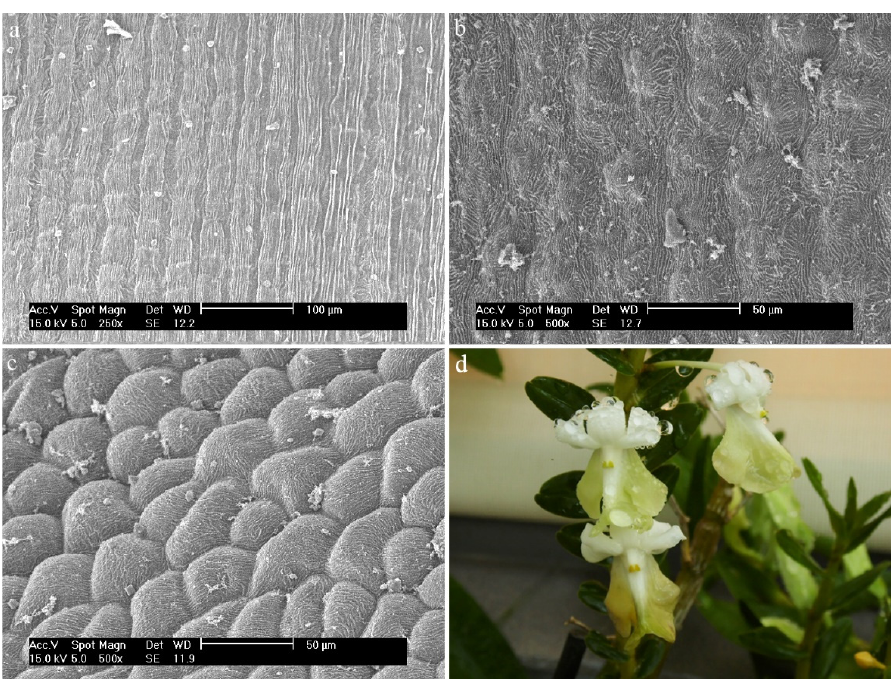
Figure 22. Dendrobium uniflorum Griff.: ( a ) the hypochile part of the labellum; ( b ) the mesochile part of the labellum; ( c ) the epichile part of the labellum; ( d ) flower (photo by Monika Lipi ń ska). 2.3.3. Dendrobium Sw. sect. Latouria (Blume) Miquel 1. Dendrobium bifalce Lindl.